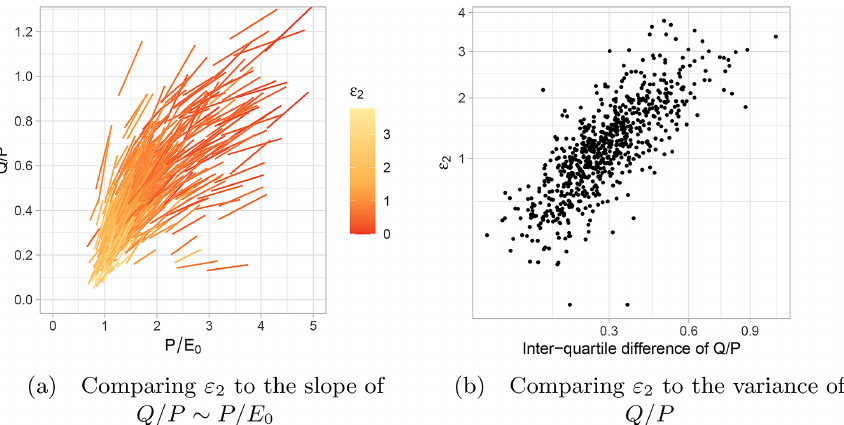
Figure 8. Comparison of the elasticity index ( ε 2 , Eq. 2) with the slope in the linear relation between Q/P and P/E 0 (a) , and with inter- quartile differences of Q/P values (b) . Slopes can be visualized for each catchment through the segments. Segments are drawn between the two points defined by the first and third quartiles of these two ratios. A square root transformation is applied to both axes.